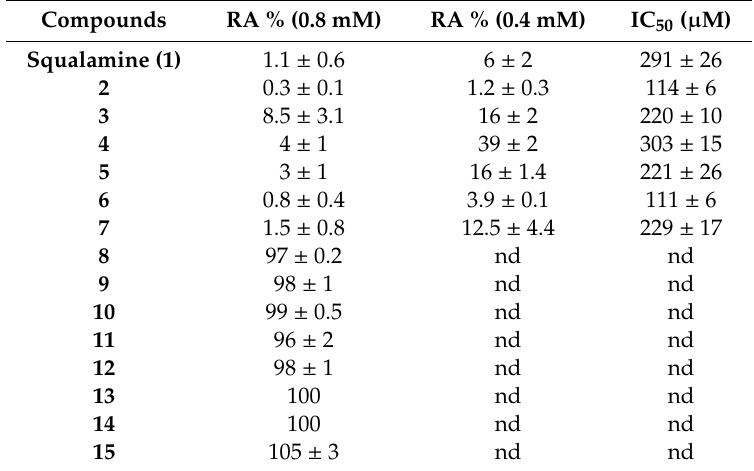
Figure 2. Inhibition of the GTase activity of PBP1b by squalamine and analogs. ( A ) TLC analysis of PG polymerase activity of PBP1b using radioactive lipid II as substrate, in the presence of squalamine and aminosterol analogs. Lanes: 1, lipid II incubated without enzyme; 2–3, lipid II incubated with 100 nM PBP1b with (2) or without (3) addition of methanol (because some compounds tested were solubilized in methanol); and SQ, 13, 14, and 10 depict the reaction incubated in the presence of 0.8 mM squalamine, or compounds 13 , 14 and 10 , respectively. ( B ) Inhibition of PBP1b GTase activity using increasing concentration of squalamine (200–1000 µ M) monitored by dansyl-lipid II based continuous fluorescence assay. ( C ) control experiment with CHAPS (1–5 mM). ( D ) a representative experiment of the RA in function of compound concentrations used for the determination of IC 50 values. The error bars represent the mean values ± s.d. of triplicate experiments. Table 1. GTase inhibition activities of squalamine and aminosterol analogues.